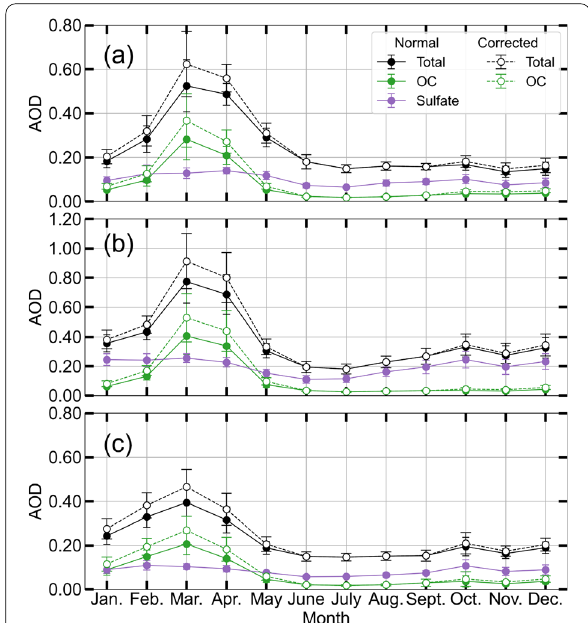
Fig. 4 Seasonal variations in AOD (black), OC AOD (green) and sulfate AOD (purple) in a NWIC, b NEIC and c SIC c from 2009 to 2020. Error bars indicate standard